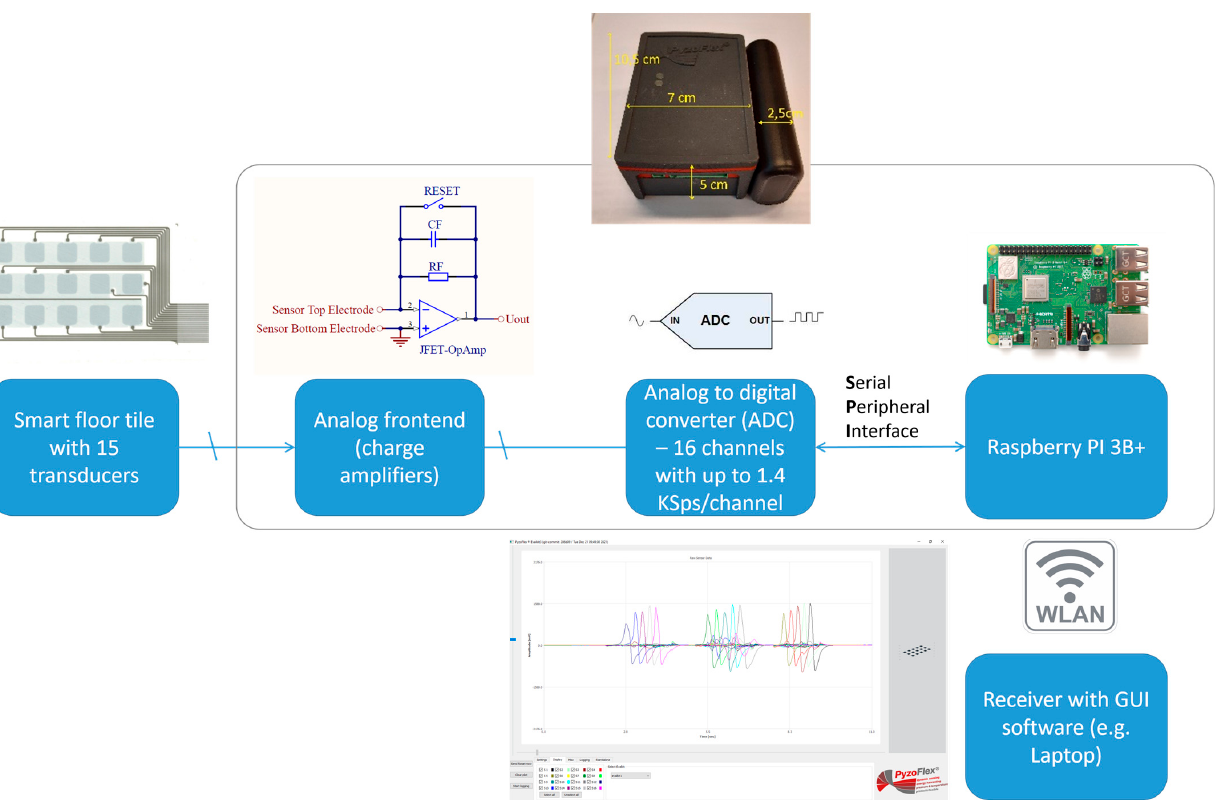
Figure 10. Block diagram of the data acquisition unit in combination with the smart floor tile